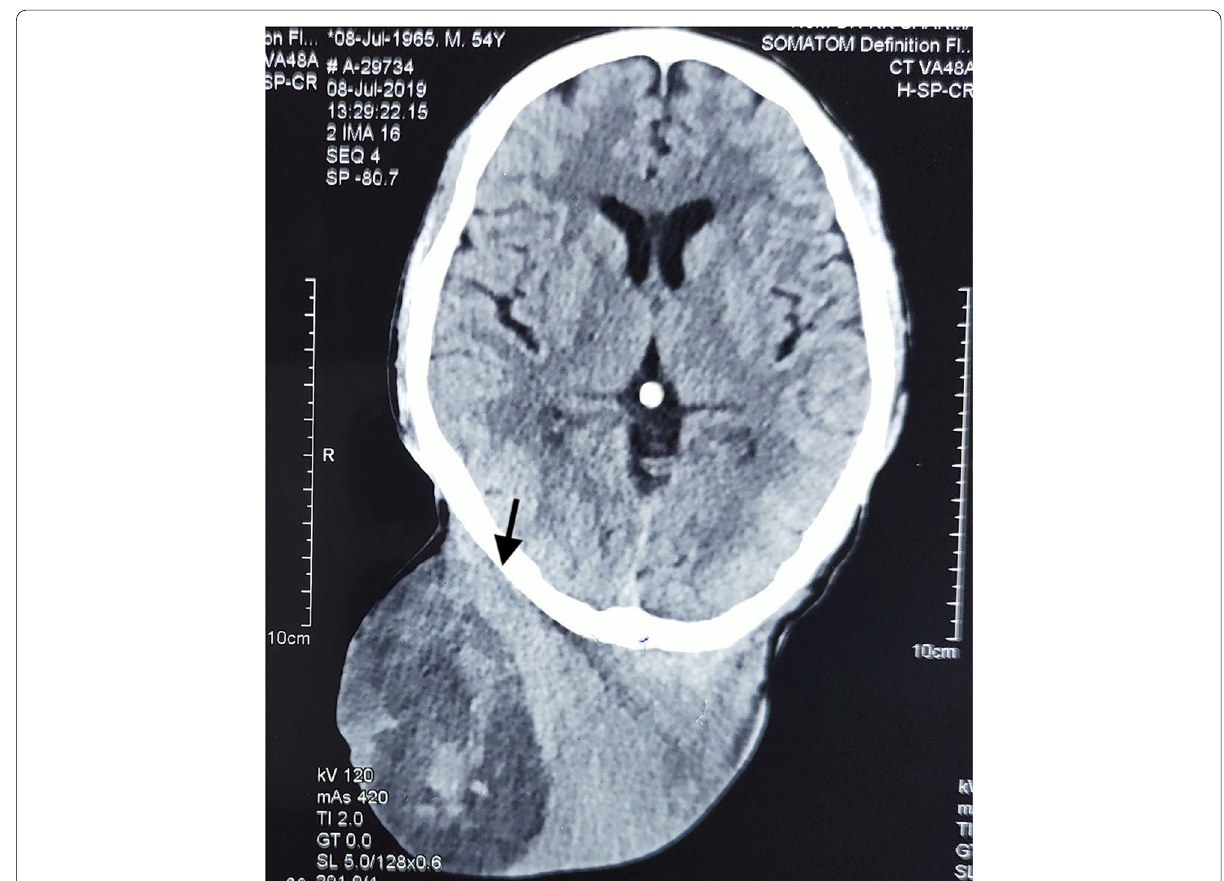
Fig. 2 CT scan of the head showing enhaced soft tissue density scalp lesion in the right parieto-occipital